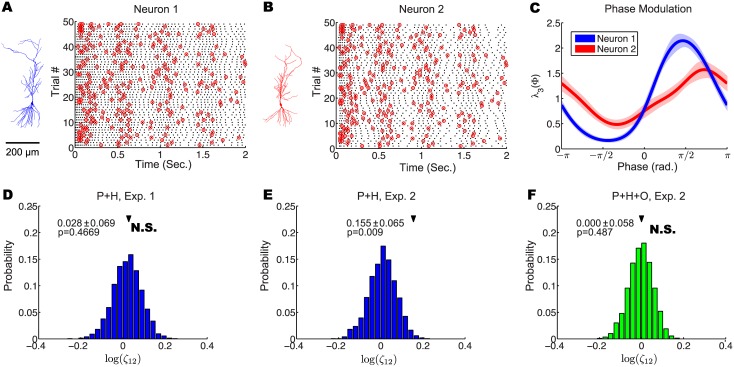
Shared oscillations contribute to spike synchrony between hippocampal CA1 pyramidal cells in vitro.(A, B) Reconstructed morphologies (left) and raster plots of spike trains (right) evoked in two CA1 pyramidal cells by an arbitrary stimulus waveform with a shared oscillatory signal (“Exp. 2”). Red circles show synchronized spikes between the two neurons. (C) Estimated phase modulation of the two recorded neurons in response to a shared oscillatory signal simulating a network-wide oscillation. (D) In the absence of a shared oscillatory signal, the simplified model (stimulus, or PSTH effects [P] + spike or auto-history effects [H]) lacking an oscillatory factor accurately predicts the observed number of synchronous spikes between the two neurons. (E,F) In the presence of a shared oscillatory signal, the simplified model (P + H) fails to explain the observed number of synchronous spikes (E) while the full model (stimulus, or PSTH effects [P] + spike or auto-history effects [H] + an oscillatory factor [O]) containing an oscillatory factor accurately predicts the observed number of synchronous spikes (F).